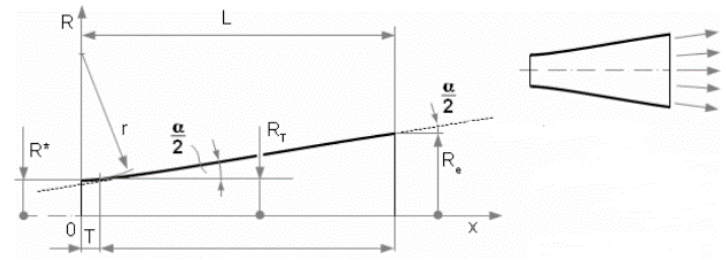
Figure 7. Laval nozzle—Bell nozzle. Reprinted from ref. [26].